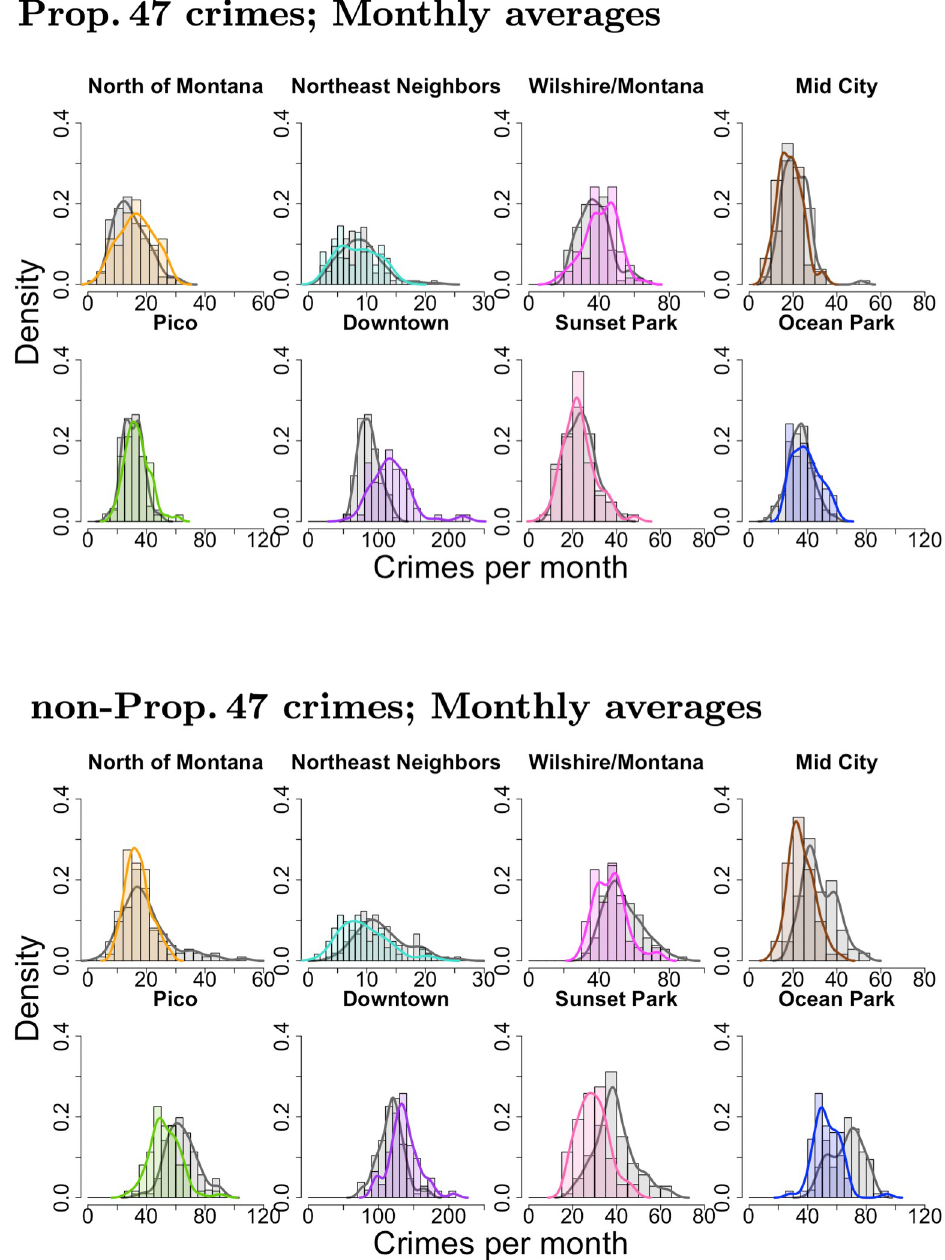
Fig 9. Neighborhood-level analysis of reported crime in Santa Monica, CA, 2006–2019. Normalized histograms and densities of Prop. 47 (top) and non-Prop. 47 (bottom) monthly crimes in the eight Santa Monica neighborhoods. The gray bars and curves represent the time period before November, 2014, and colored ones represent the period after. Table 2 provides summary